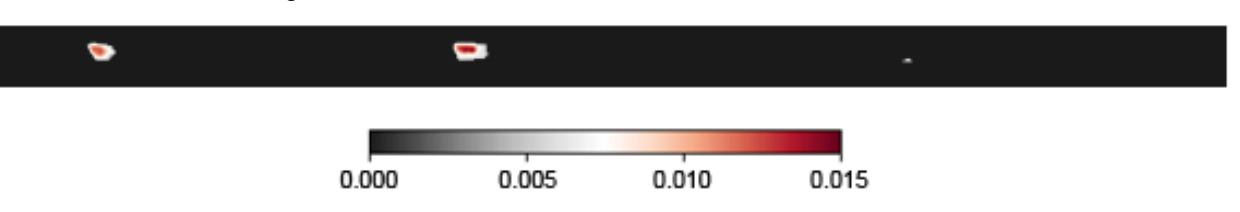
Figure 16. Raster of relative belt surface elevation (values in meters).